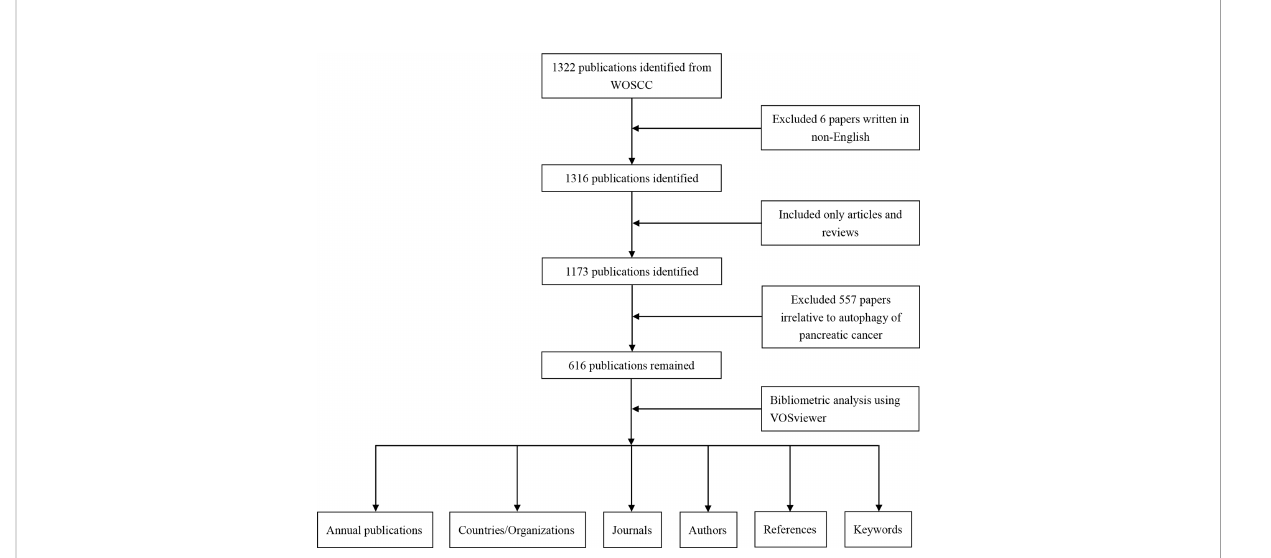
FIGURE 1 Flow chart of the data collection and analysis for research on autophagy of pancreatic